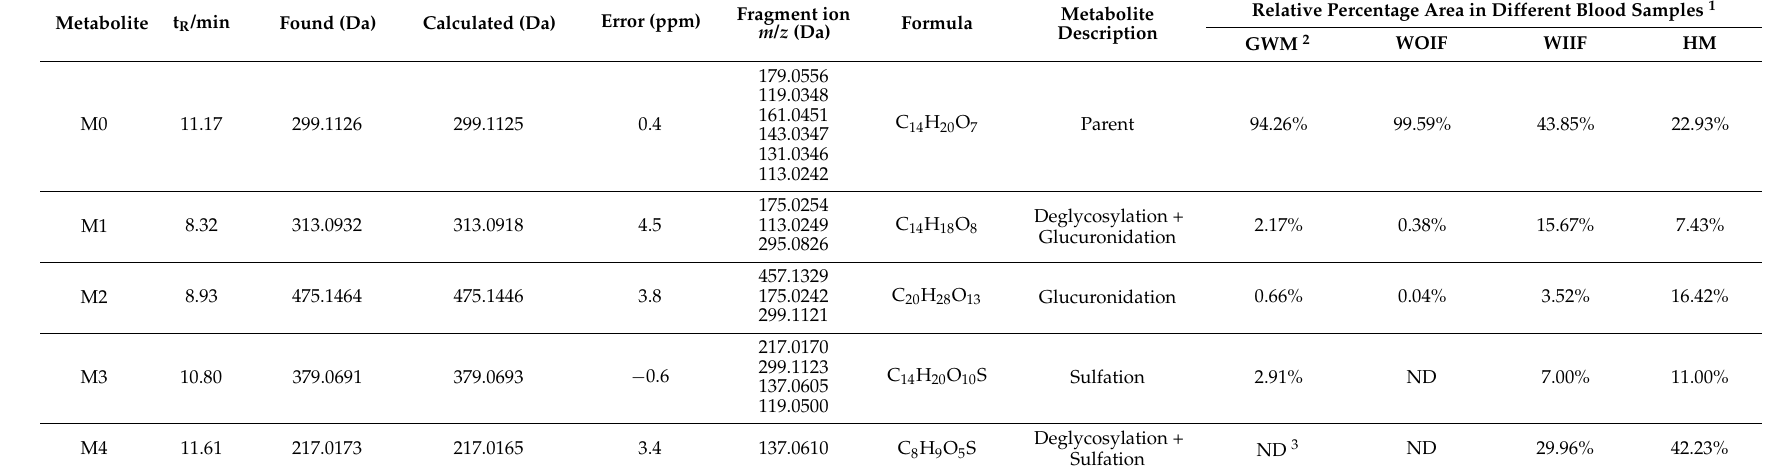
Table 1. UHPLC-LTQ-Orbitrap analysis and relative percentage area of salidroside and four metabolites in different blood